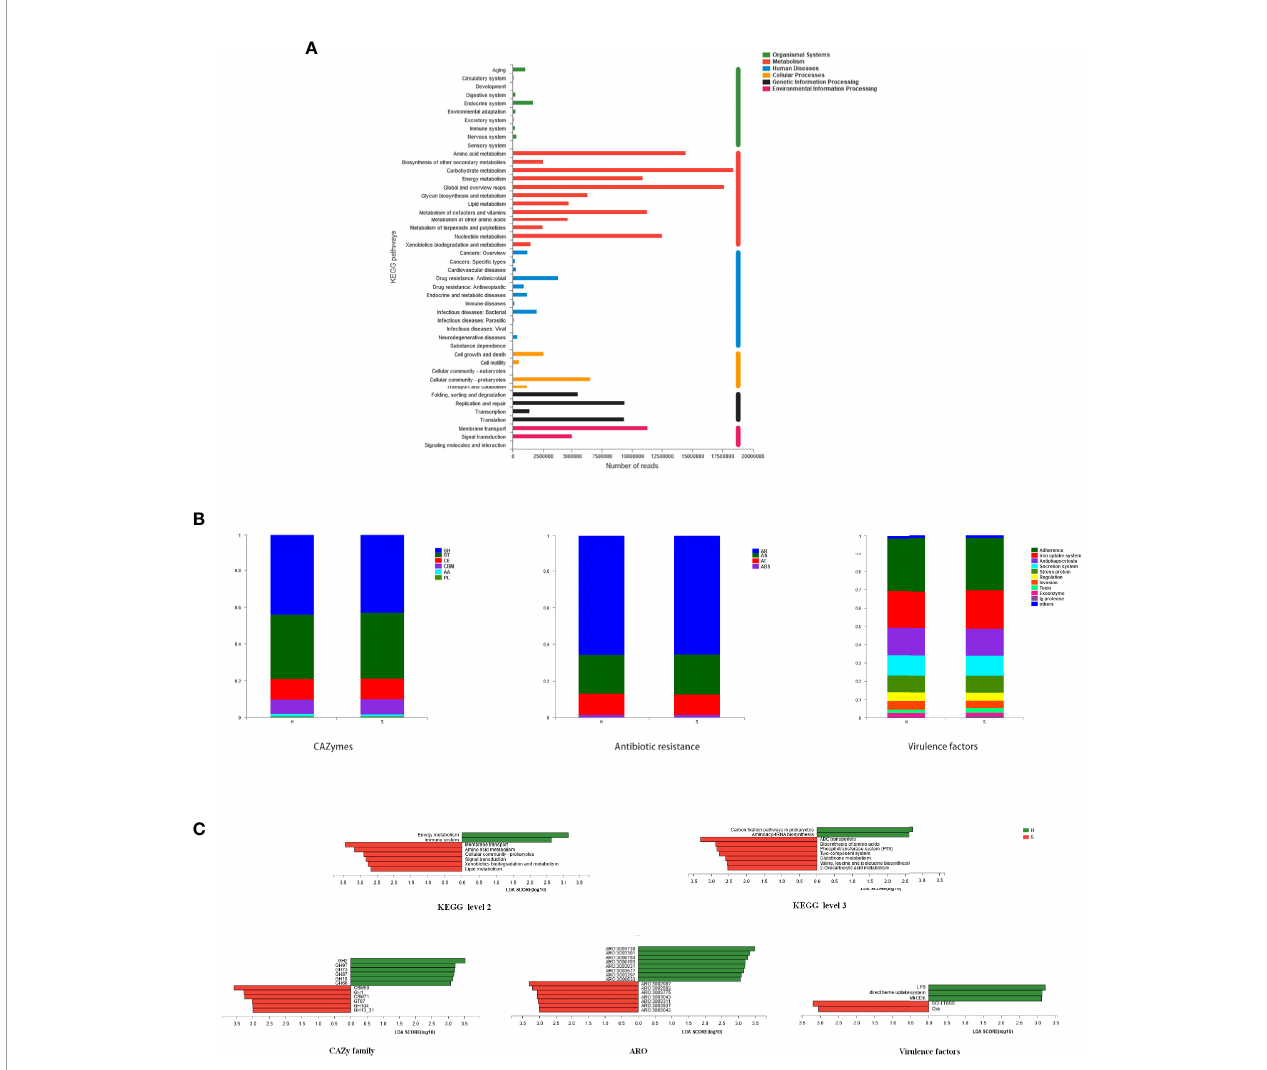
FIGURE 4 | Functional genes of the salivary microbiome. (A) Genes related to KEGG pathways. Each branch represents a KEGG pathway on level 2, and different colors represent different KEGG level 1 functions. (B) Genes related to speci fi c functions. The predominant taxa (relative abundance>2% on average) of CAZyme class genes, genes related to antibiotic resistance on class level, and genes related to virulence factors on level 2 are shown. (C) Potential biomarkers de fi ned by LDA scores. Differentially abundant KEGG pathways on level 2 and level 3 (LDA > 2.5, P < 0.05) and differentially abundant CAZyme families, AROs, and virulence factors (LDA > 3, P < 0.05) were